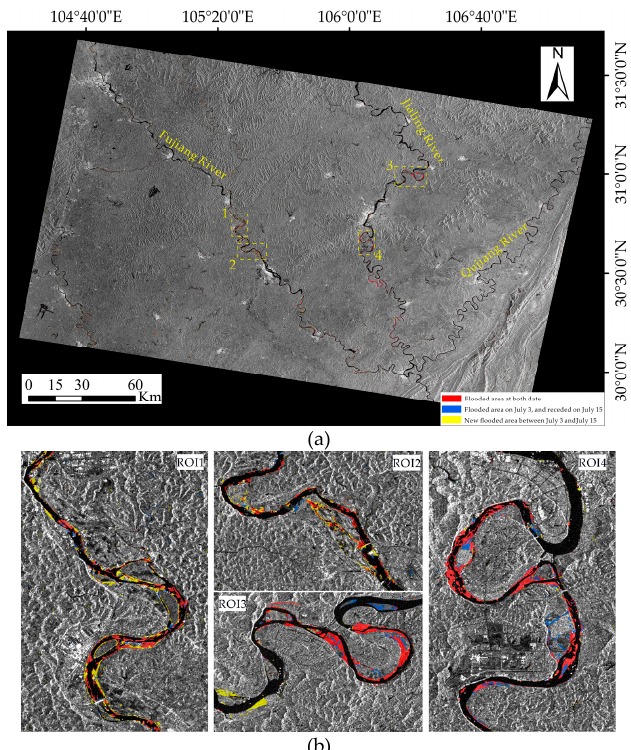
Figure 11. ( a ) Flood dynamics for the study area on 3 and 15 July 2018 overlaid on the pre-flood SAR image on 4 May 2018; ( b ) four ROIs selected in correspondence to the numbered yellow-dotted